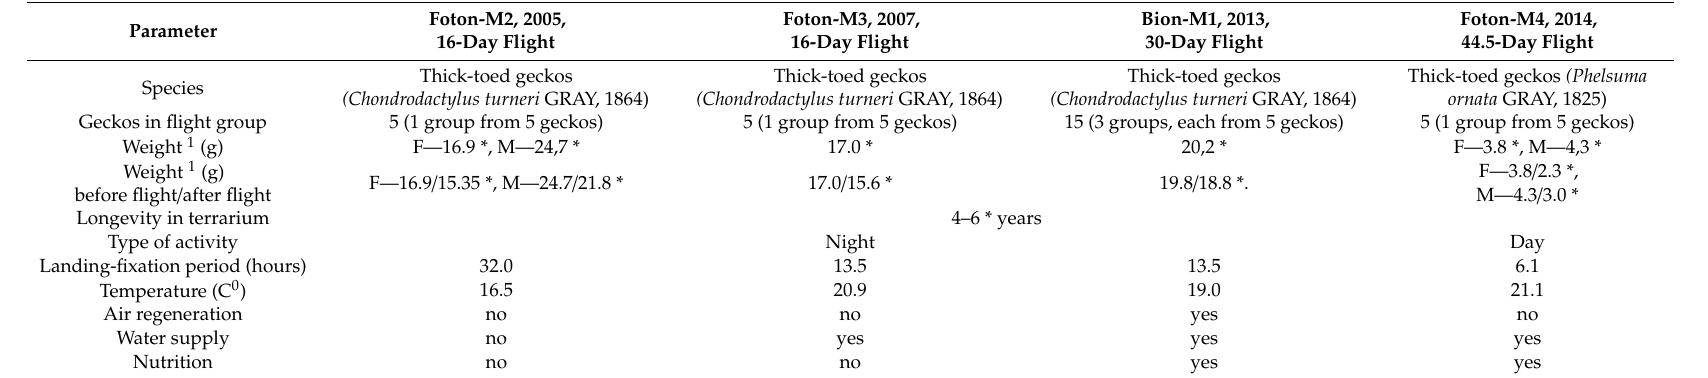
Table 2. The main parameters of the gecko orbital